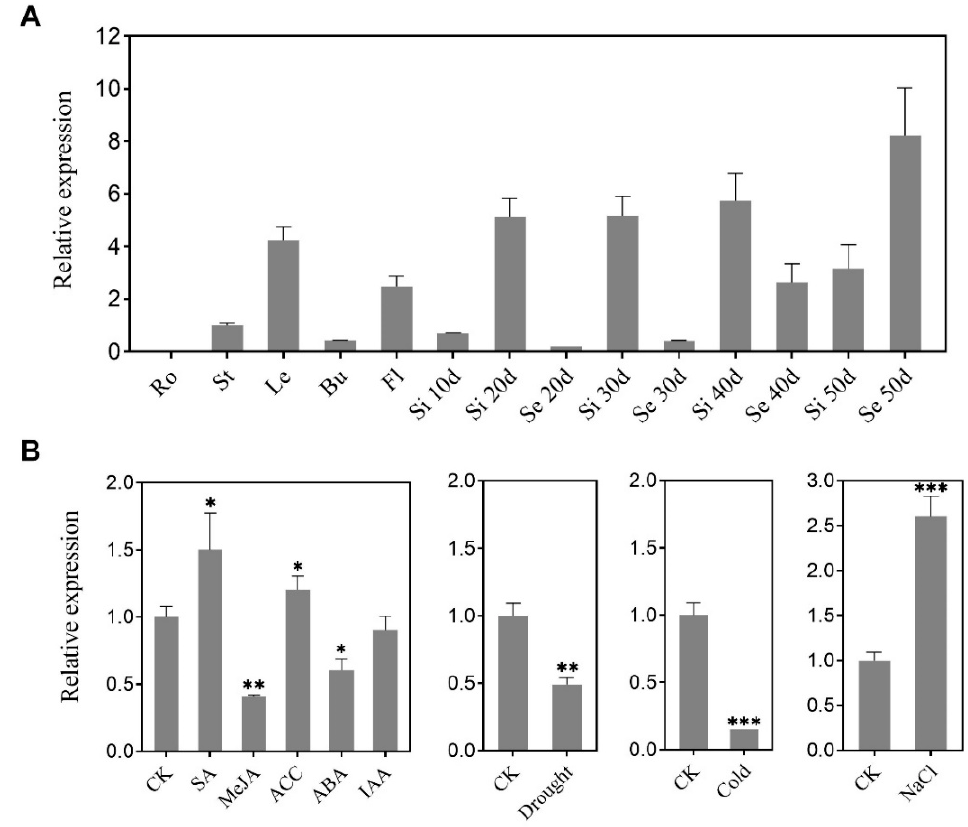
Figure 3. Expression pattern of BnaC9.DEWAX1 gene. ( A ) qRT-PCR analysis of BnaC9.DEWAX1